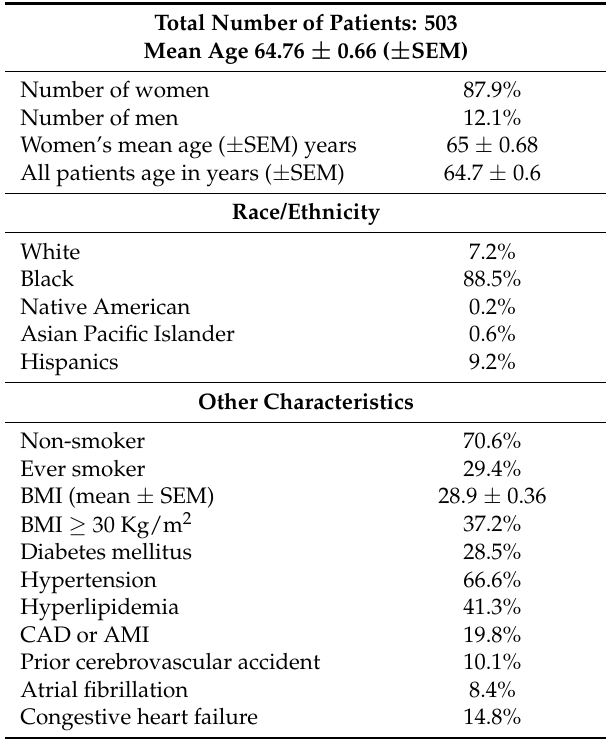
Table 1. Population